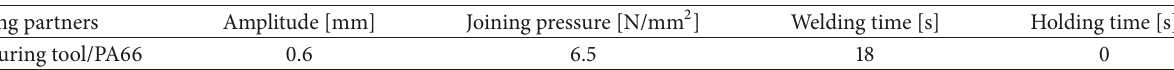
Table 2: Parameter settings of prestructuring process.